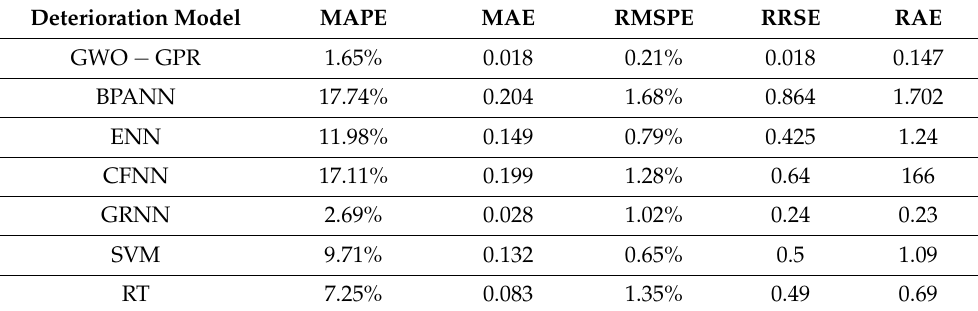
Table 3. Performance comparison between deterioration prediction models of cast-in-place tun- nel